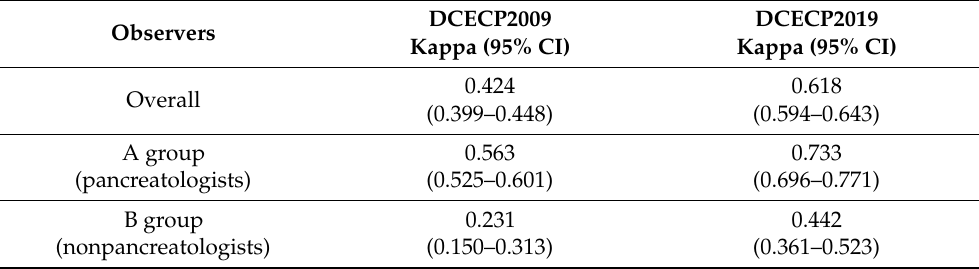
Table 4. Interobserver reliability of EUS criteria in DCECP2009 and DCECP2019.